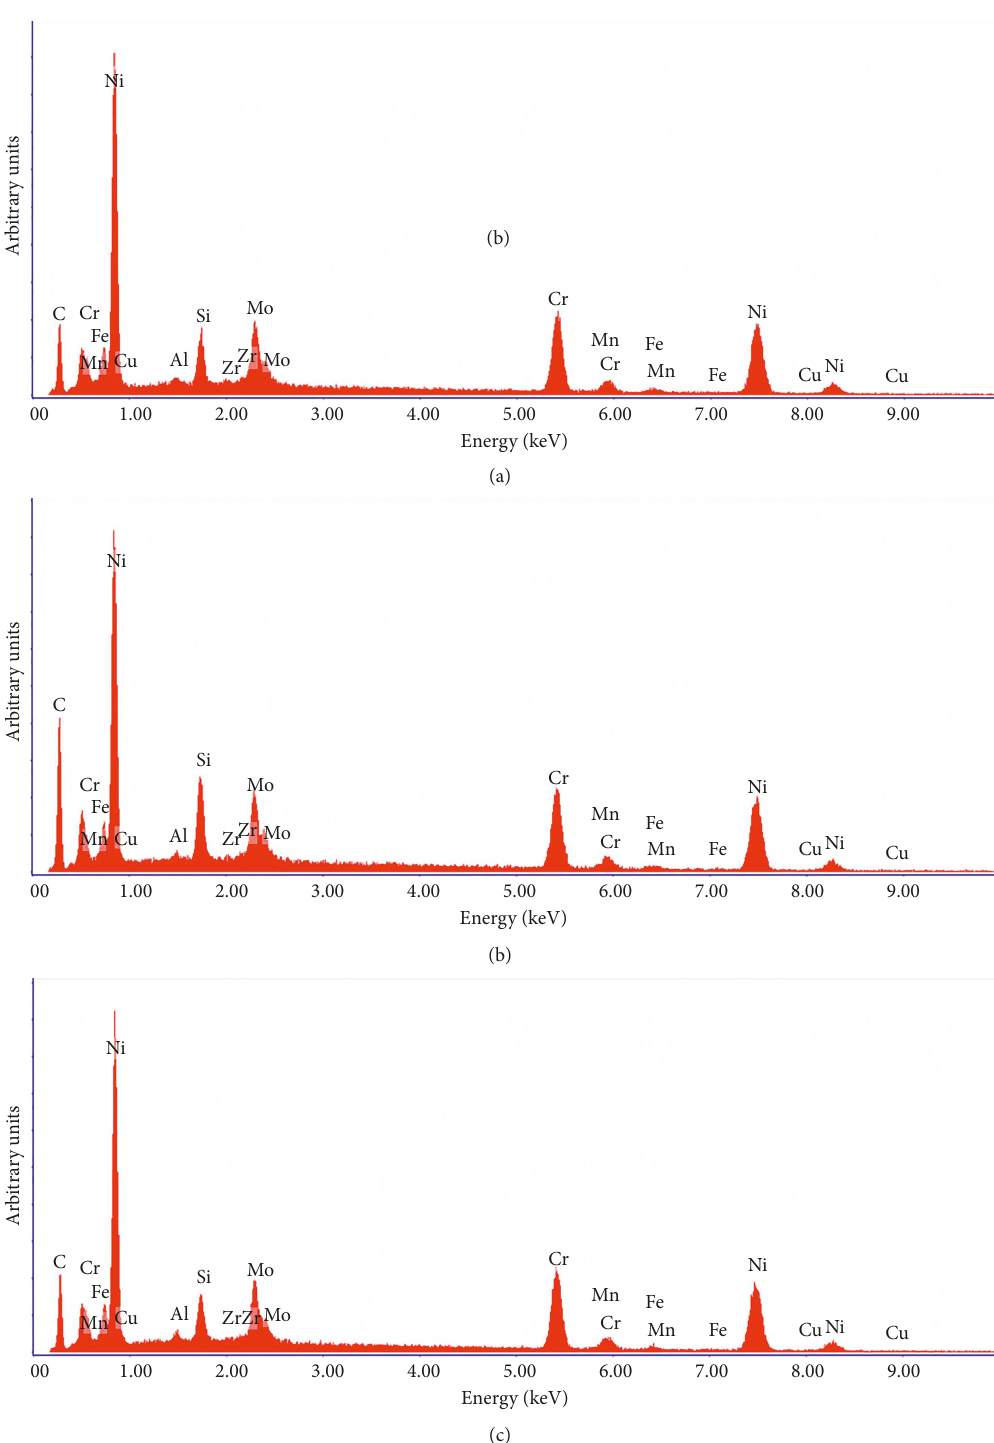
Figure 3: The results of chemical compositions analyses (EDS). (a) Sample 0. (b) Sample 50. (c) Sample